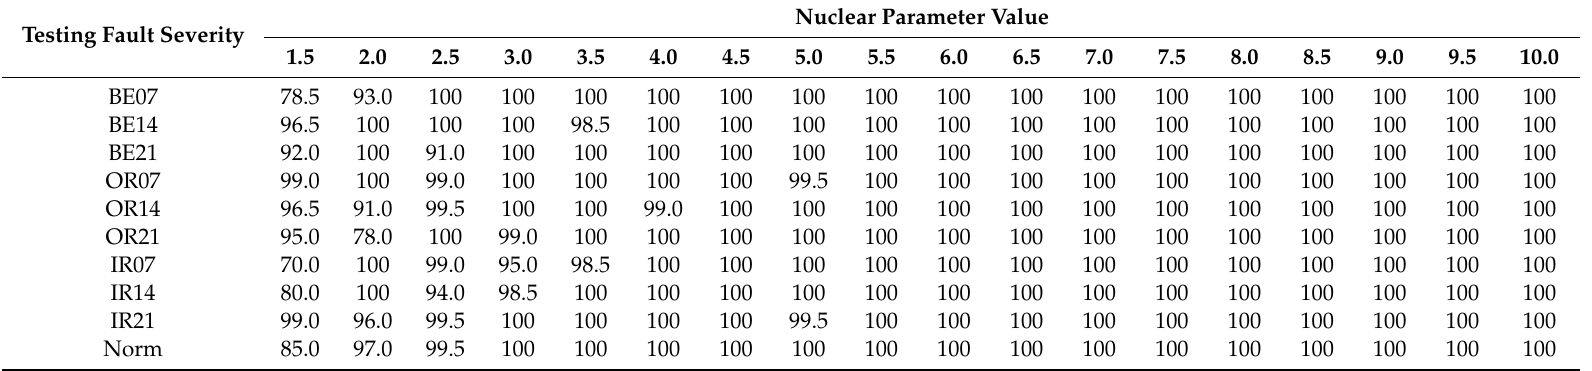
Table 16. The influence of nuclear parameter selection of the mRVM 1 _conv 2 on fault identification accuracy of the rolling bearing (%). Testing Fault Severity